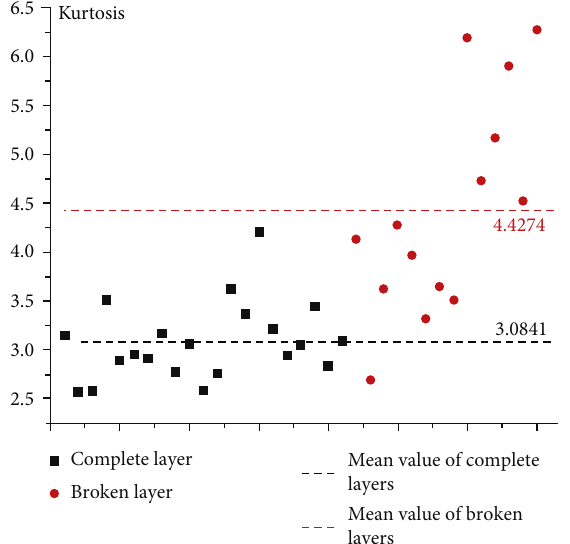
Figure 7: Kurtosis scatter diagram.